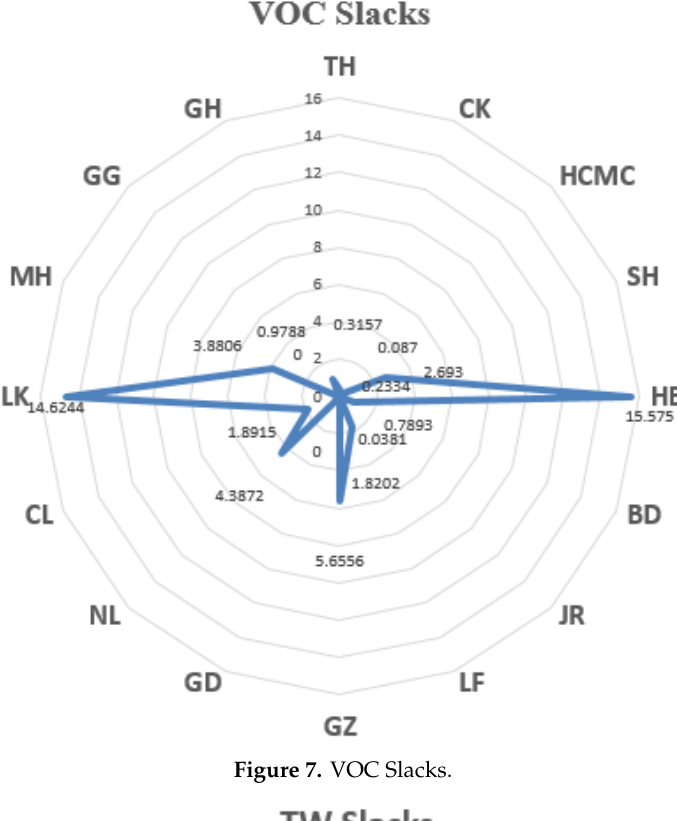
Figure 7. VOC Slacks.